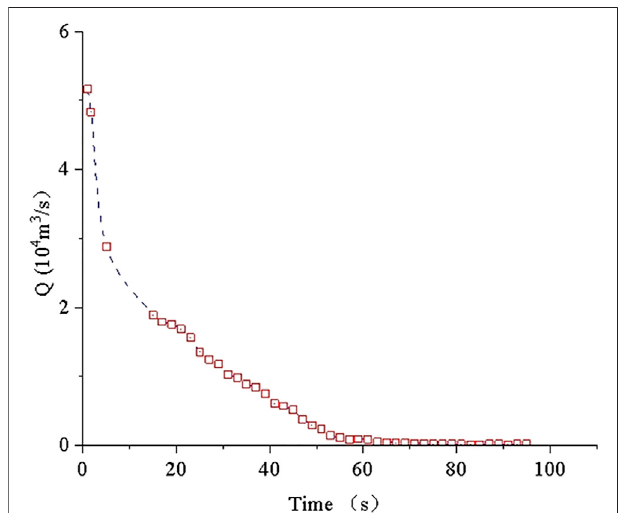
FIGURE10| Changeinquantityof fl owatthebottomofthetailingsdam.